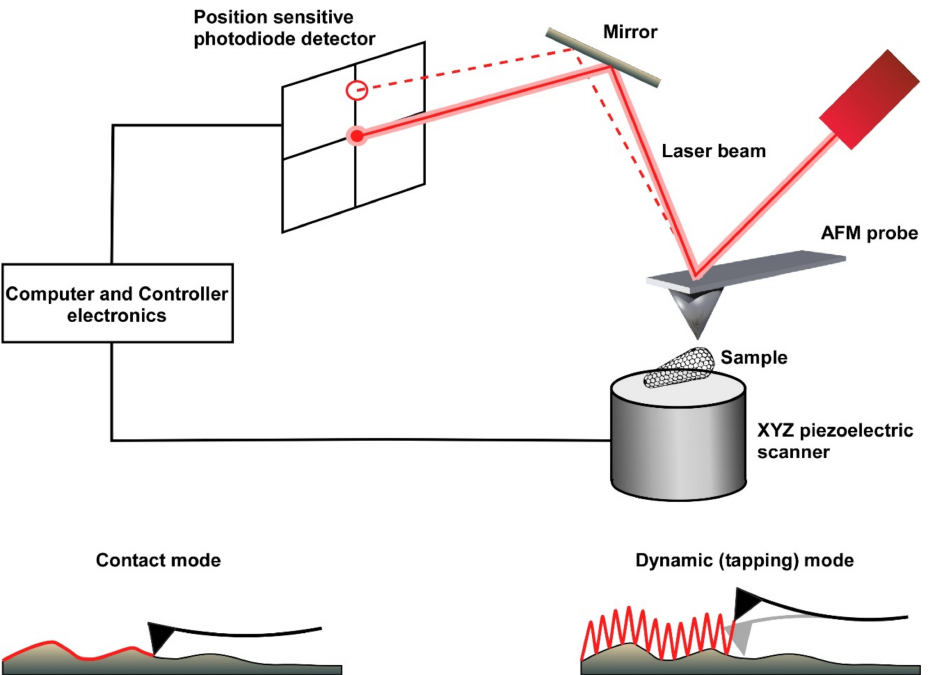
Figure 1. A schematic drawing of the main components of an atomic force microscope (AFM). The AFM is composed of an XYZ piezoelectric scanner, a laser source, a position-sensitive photodiode detector (PSD), and a controller. The AFM probe is a sharp tip that is attached to the end of a cantilever. A laser beam is reflected onto the PSD to detect small deflections of the cantilever as it scans the sample topography at very high force sensitivity. The two principal imaging modes of AFM, contact and dynamic modes, are schematically displayed. Contact mode is probably the simplest AFM imaging mode. In this mode, the probe is in continuous contact with the sample while scanning the surface at a constant force. In dynamic mode, the cantilever oscillates at or near the resonance frequency of the cantilever. As a result, the probe interacts with the sample as the probe “taps” along the surface, reducing the interactions between the sample and the probe. This mode is particularly powerful for imaging soft and gentle biological